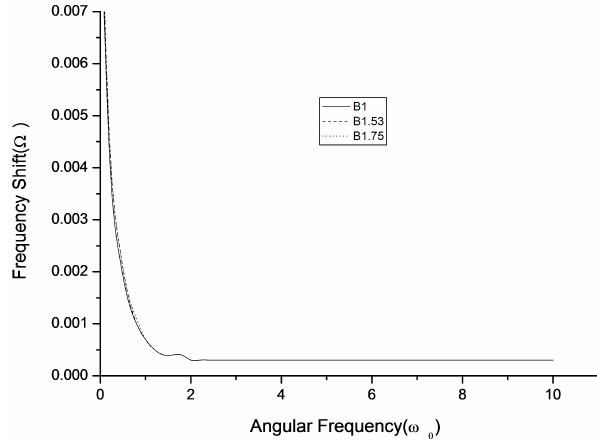
Figure 5: Variation in damping with respect to angular frequency ( α = 0.75) .